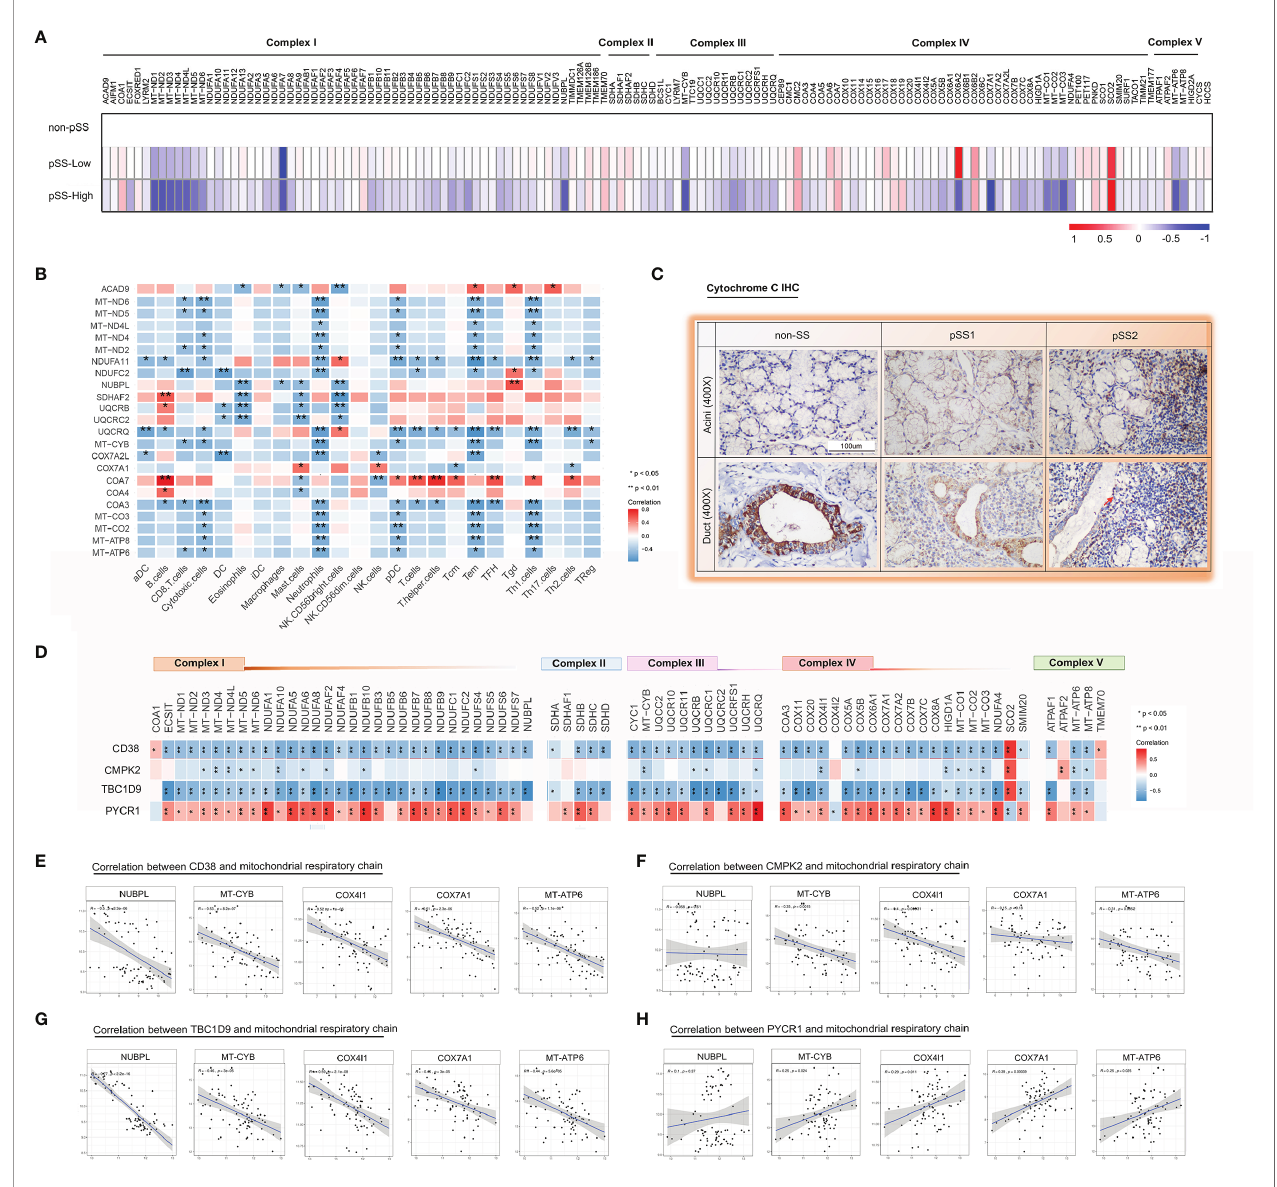
FIGURE 5 | Impaired mitochondrial respiratory chain complexes in the salivary glands from pSS. (A) A heatmap shows signi fi cant down regulation in the bulk respiratory chain complex (I – V) genes in pSS from the validation cohort, particularly those encoded in the mitochondria in pSS-high-in fi ltration group. (B) Heatmap of the Spearman correlation values between respiratory chain complex (I – V) genes and immune responses in pSS from the validation cohort. (C) Immunohistochemical staining for cytochrome c of paraf fi n-embedded labial salivary gland specimens from our own cohort. Scale bar = 100 m m. (D) Heatmap of the Spearman correlation values between respiratory chain complex (I – V) genes and 4 hub genes (CD38, CMPK2, TBC1D9, and PYCR1) in pSS from the validation cohort. (E – H) Scatter plot depicted the correlation between interested respiratory chain complex genes (MT-CYB, MT-ATP6, COX7A1, NUBPL, COX4I1, CYCS) and CD38 (E) , CMPK2 (F) , TBC1D9 (G) , and PYCR1 (H) based on the data from Figure 6D ,